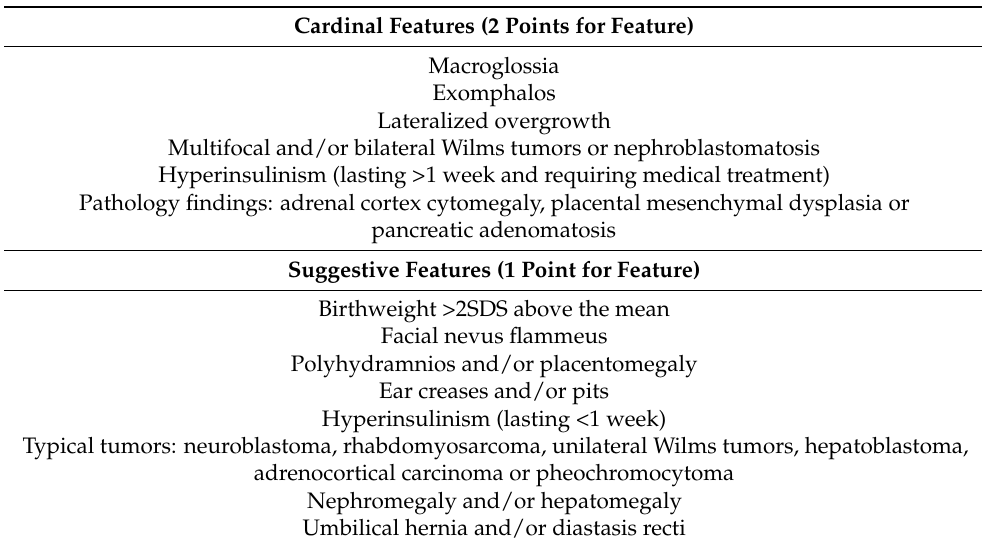
Table 3. Classification of BWS clinical signs according to the Beckwith-Wiedemann spectrum (BWSp) scoring system